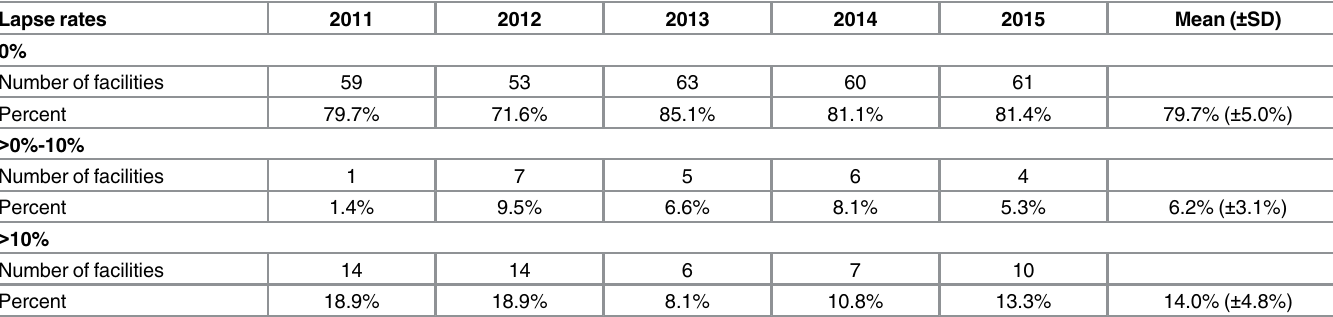
Table 4. Number of facilities with various institutional animal care and use committee continuing review lapse